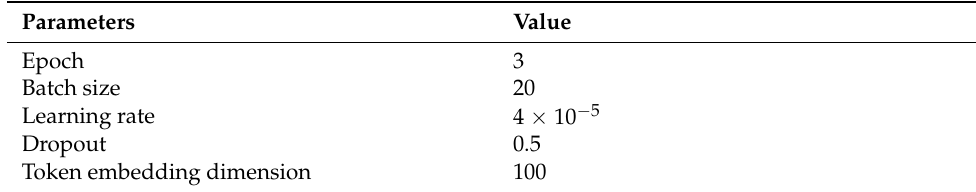
Table 2. Experimental